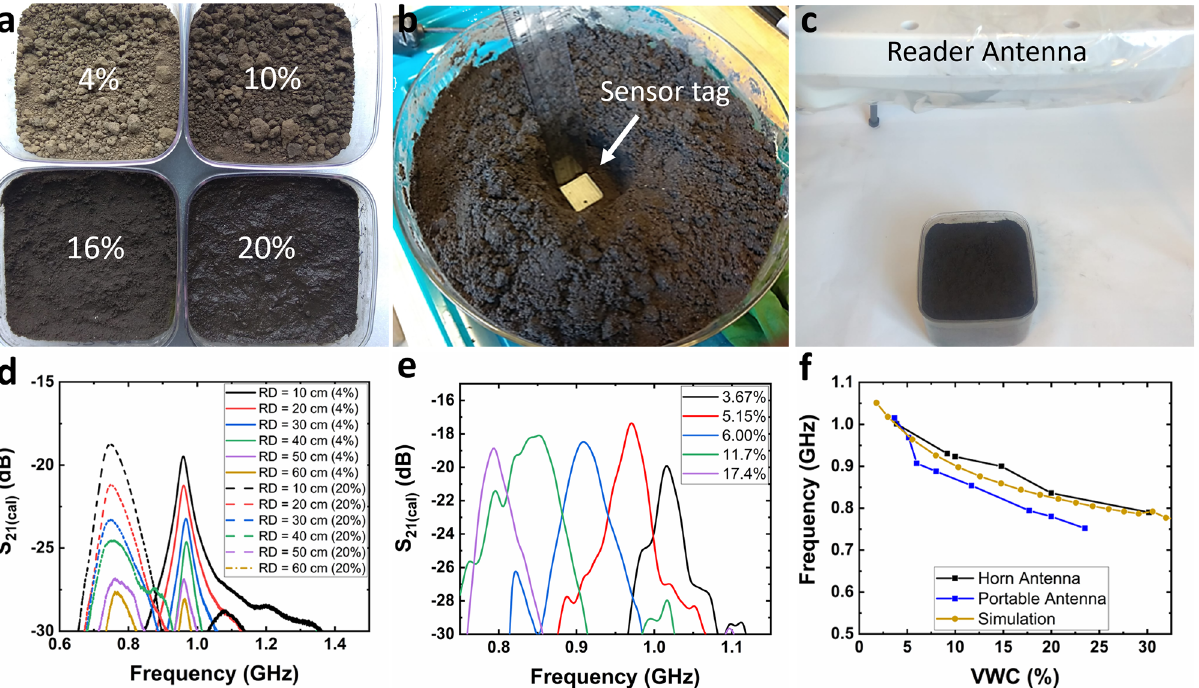
Figure 5. Experimental studies with DIRTS buried in the soil samples ( a ) Soil samples with VWC 4%, 10%, 16%, and 20%. ( b ) Demonstration of the placement of DIRTS at a depth of 5 cm in a soil sample. ( c ) The portable antenna aligned centering the sample to obtain maximum reflections. ( d ) S 21 ( cal ) vs. frequency measured with the portable reader for different read distances (RD) and VWCs demonstrating a reduction in S 21 ( cal ) as a function of RD ( e ) S 21 ( cal ) vs. frequency measured with the portable reader for different VWCs when RD = 40 cm showing a shift in f r with VWC. ( f ) Resonant peaks extracted from S 21 ( cal ) vs. frequency curves measured with the portable reader plotted as a function of VWC. Measured results from the anechoic chamber experiments as well as the results from simulations plotted for placed at RD = 40 cm (Supplementary Text ST5). The results indicated that the optimum angular orientation required to obtain an amplitude reduction of < 3 dB is 0° to 45° (Fig. S2) corroborating the simulation results obtained from the radiation pattern in Fig. 1h. After identifying the optimum read distance as 40 cm and the best angular orientation as 0°–45° the response of the sensor tag to varying moisture conditions was studied using the custom-designed portable reader setup in Fig. 5c. The ground truth VWC measurements were obtained from a Teros 12 reader and were correlated to the f r obtained from the portable reader measurements to develop a calibrated curve. As shown in Fig. 5e, when the VWC of the soil was increased from 3.67% to 17.7%, f r was reduced from 1.015 GHz to 0.794 GHz,